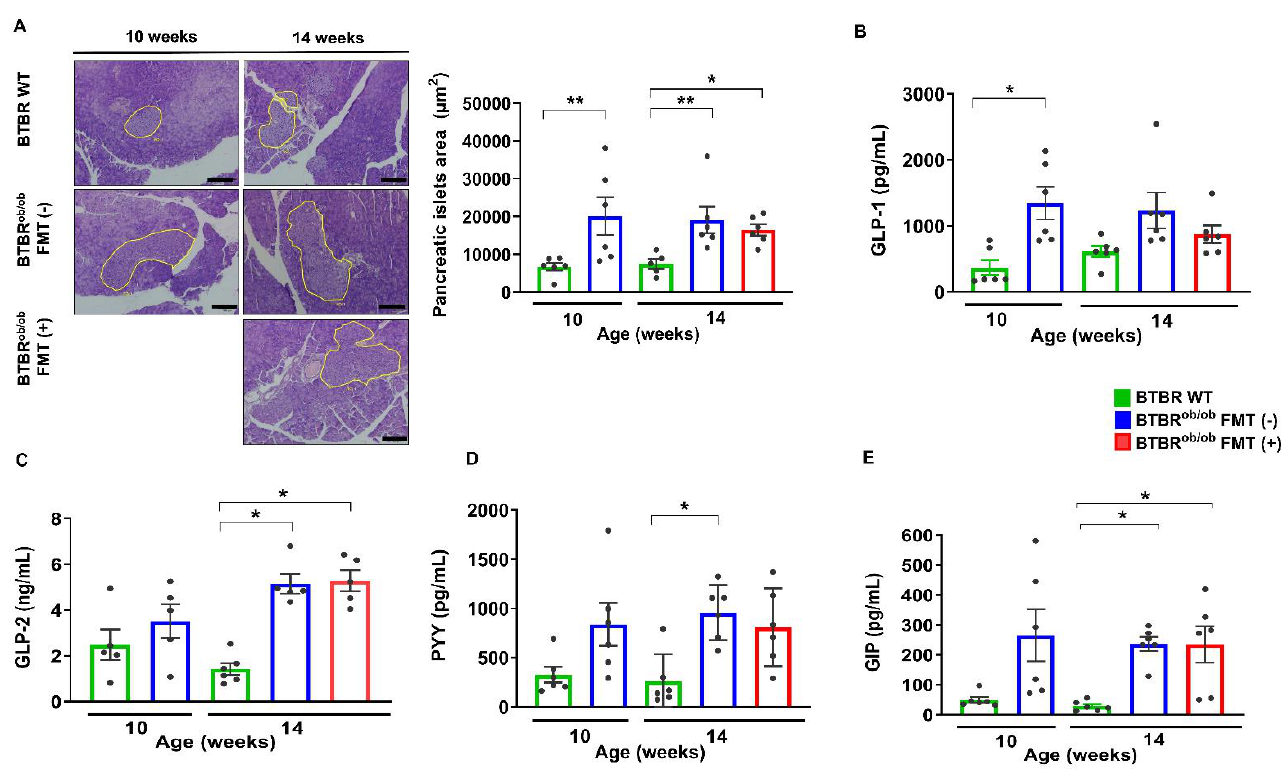
Figure 3. Analysis of morphological and metabolic parameters in BTBR ob/ob FMT (+) and FMT (-) mice compared to BTBR WT mice. ( A ) Representative hematoxylin-eosin (HE) staining of morphological evaluation of pancreatic islets in 10-week-old BTBR WT compared to age-matched BTBR ob/ob mice and 14-week-old BTBR WT compared to BTBR ob/ob FMT (+) and FMT (-) mice. Data exhibited hypertrophy of the pancreatic islet in 10-week-old BTBR ob/ob mice when compared to age-matched BTBR WT mice (** p = 0.005), and between BTBR ob/ob FMT (-) (** p = 0.008) and FMT (+) (* p = 0.01) versus 14-week-old BTBR WT mice. No difference was observed between BTBR ob/ob FMT (-) and FMT